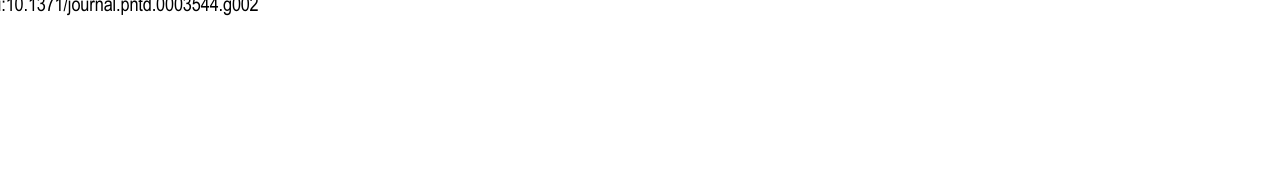
PLOS Neglected Tropical Diseases | DOI:10.1371/journal.pntd.0003544 March 4,